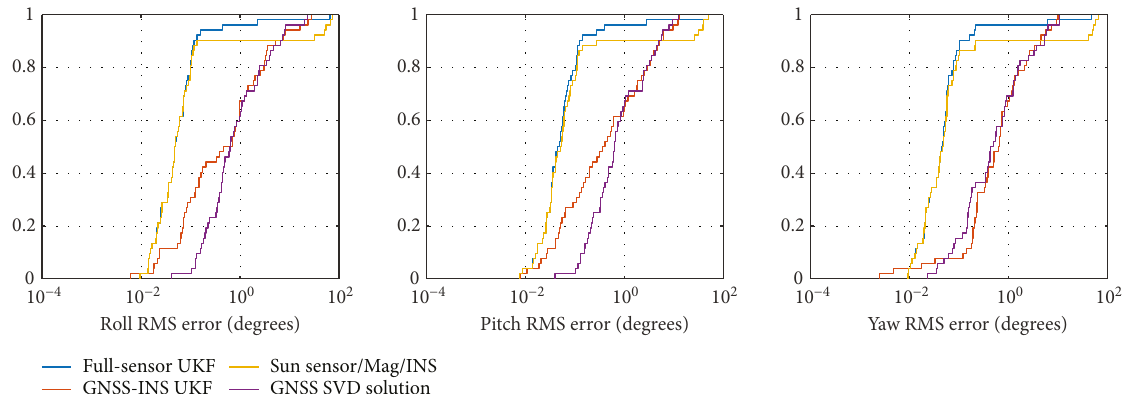
Figure 7: Comparison between GNSS-SVD solution and multisensor attitude fi lter in di ff erent modes — roll, pitch, and yaw error. roll, and heading error statistics for both fi lter modes are pre-